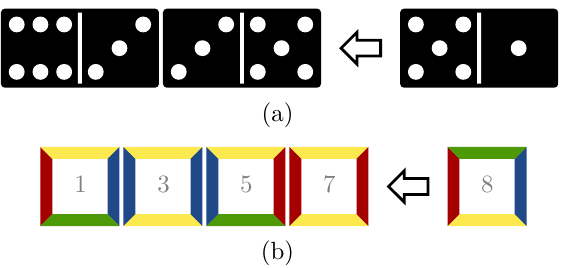
Figure 3. Principle of Wang Tiles method, a) domino game, b) Wang Tiles.